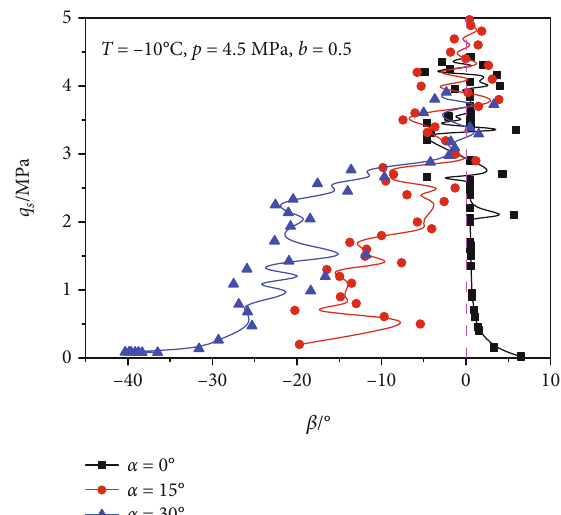
Figure 15: Variations of non-coaxial angle with shear stress under di ff erent principal stress directions.